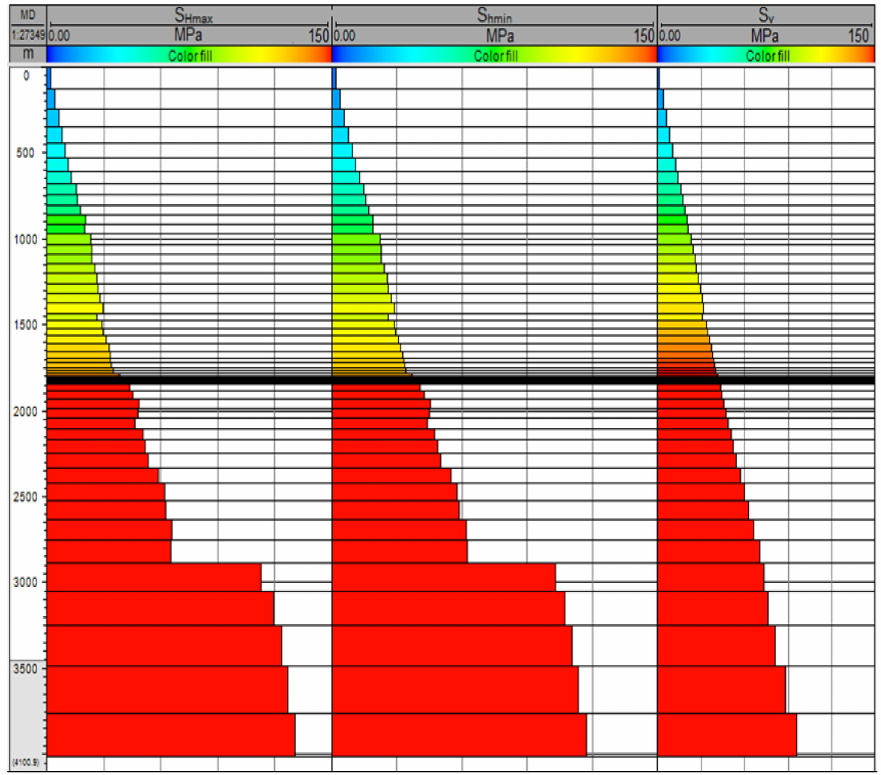
Figure 15. Stress state of randomly proposed well with principal stresses: maximum horizontal stress ( S hmin ), minimum horizontal stress ( S hmin ), and vertical stress ( S v